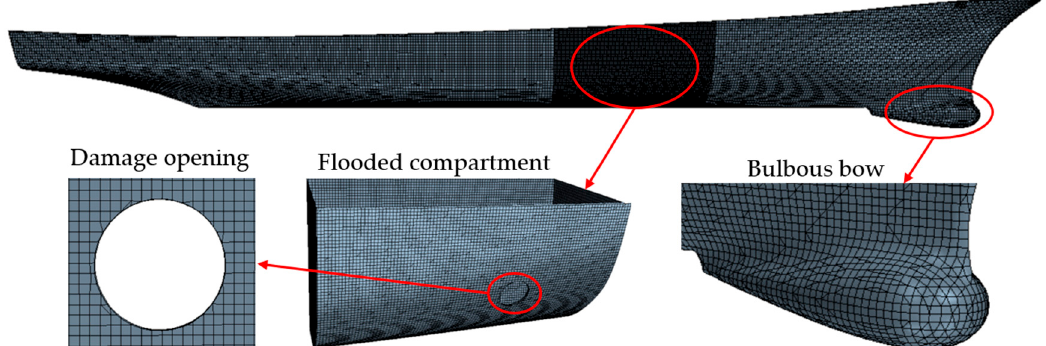
Figure 10. Volume mesh of the hull and refinement details of the local blocks.